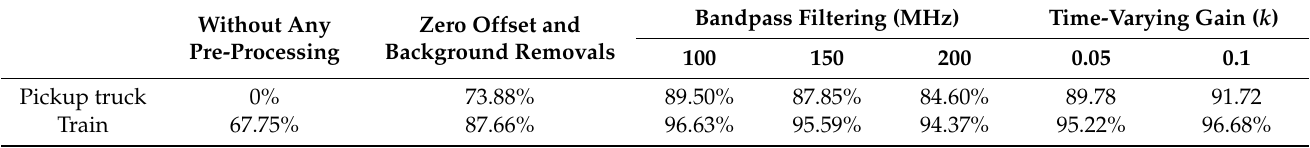
Figure 18. B-scan images collected using the maintenance train-mounted GPR system on the railway and obtained from performing the time-varying gain: ( a ) k = 0.05; ( b ) k = 0.1. Table 3. Performance of the detection of the proposed GPR system.